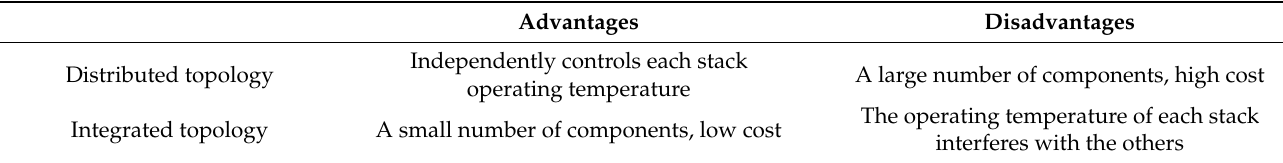
Figure 1. Topologies of the MFCS thermal management subsystem: ( a ) distributed and ( b ) integrated. Table 1. The advantages and disadvantages of the two topologies.